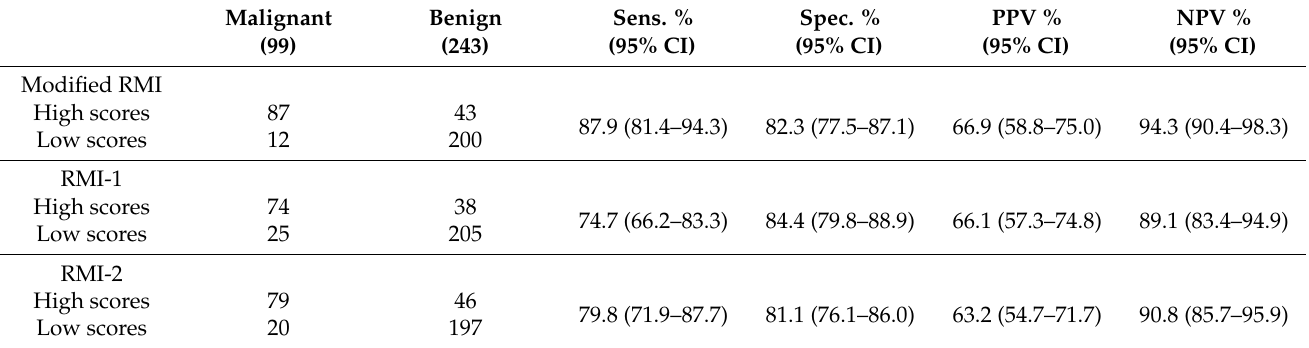
Table 2. Diagnostic performance of risk of malignancy index (RMI) in predicting malignant ovarian